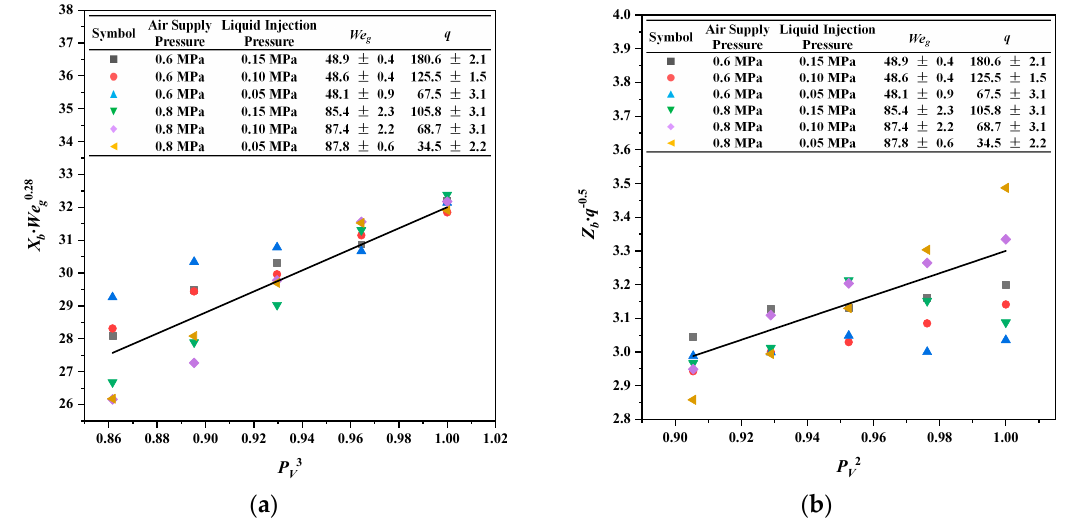
Figure 16. Fitting curves and experimental data for the column fracture position. ( a ) X -positions change with P V 3 ; ( b ) Z -positions change with P V 2 .